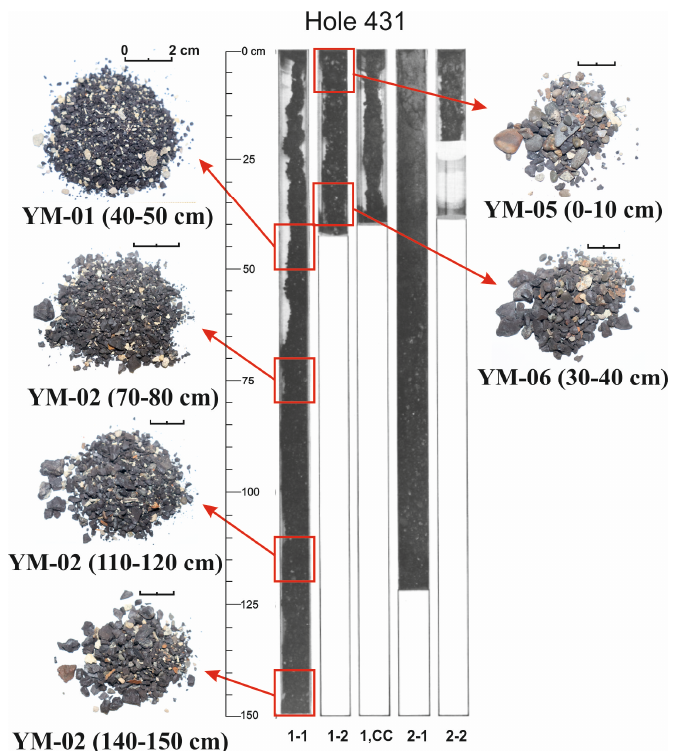
Figure 3. Fragments of Fe-Mn deposits from Hole 431 DSDP and sampling interval location (core photo from [27]. Minerals 2019 , x FOR PEER REVIEW